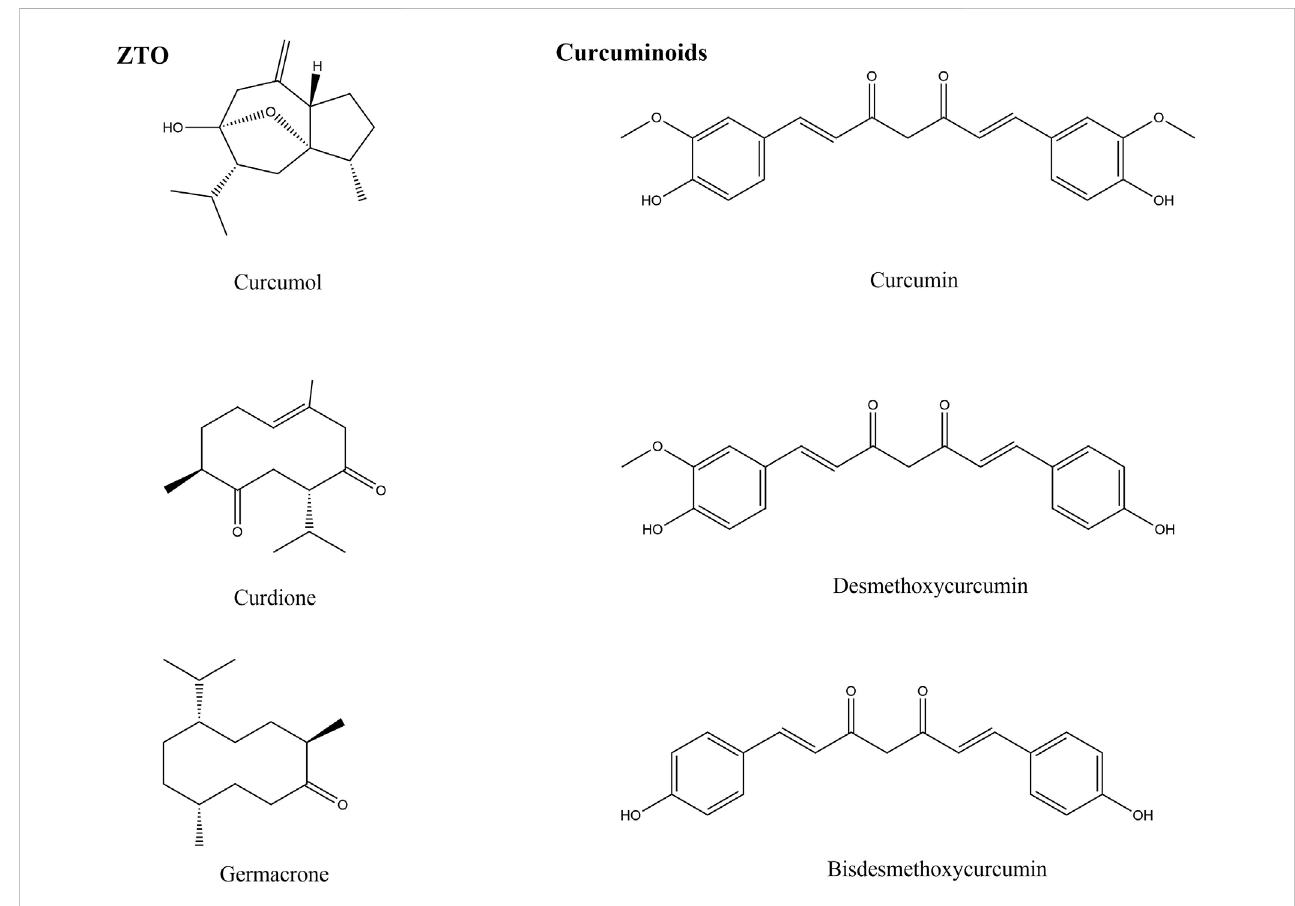
The chemical structures of active components in ZTO and